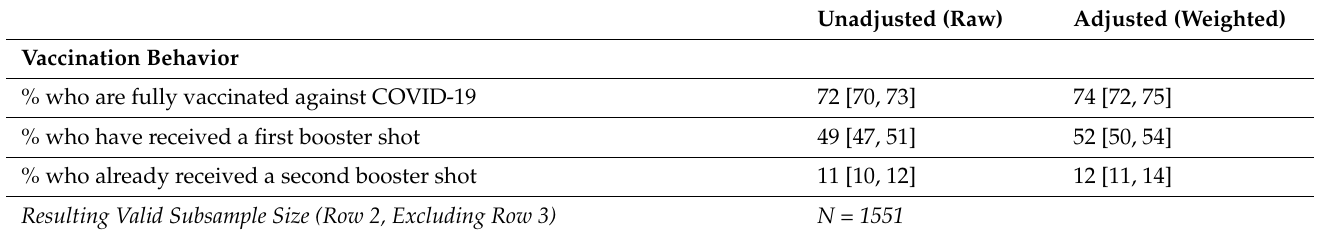
Table 1. Raw and Weighted Summary Statistics: Vaccine Attitudes and Reported/Intended